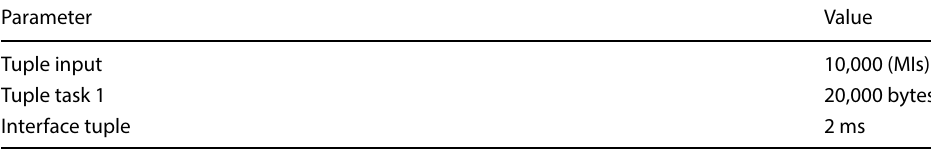
Table 3 The configuration